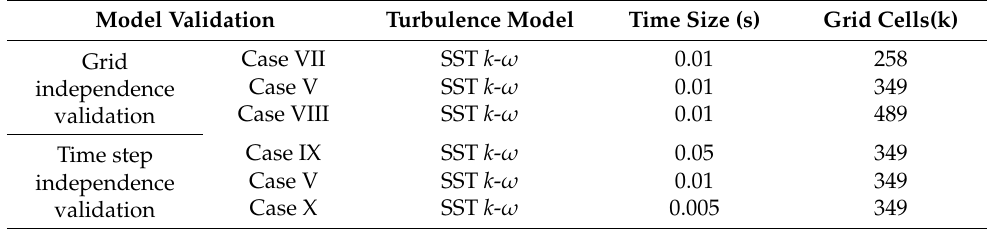
Table 2. Details of the cases for model validation.